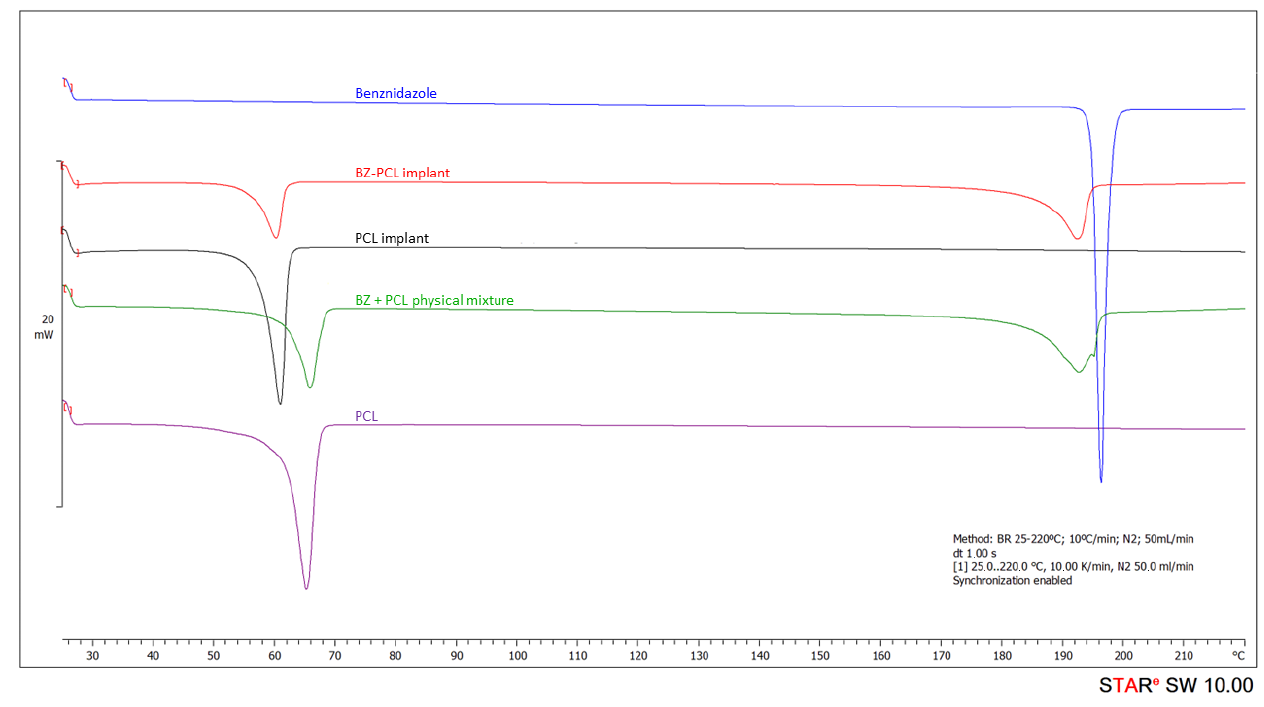
Figure 4. Differential scanning calorimetry (DSC) curves of BZ – PCL3 implant (ratio 1:1.33) (red), blank-PCL implant (black) and pure benznidazole (blue), physical mixture of PCL + benznidazole (1:1.33) (green) and PCL polymer (purple).